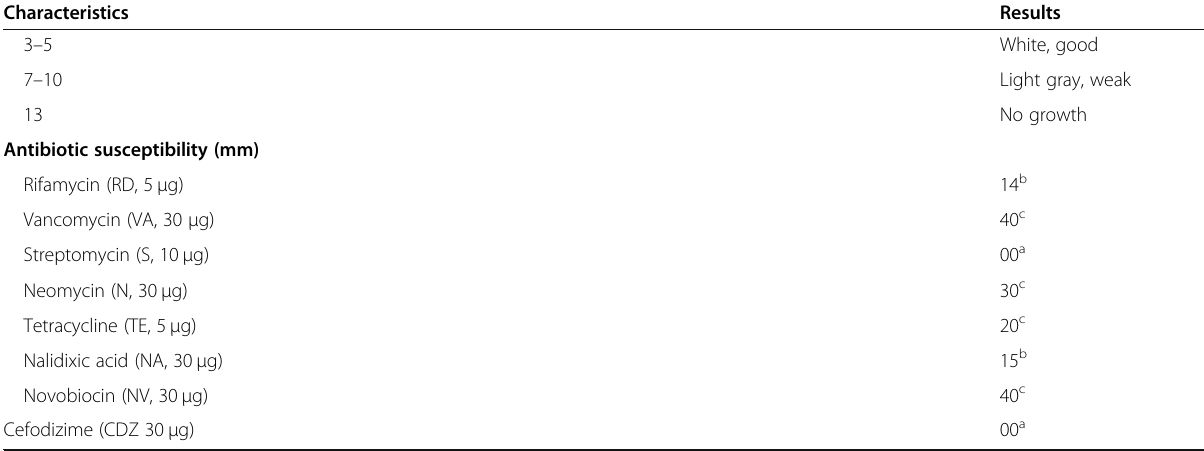
Table 2 Morphological, physiological, and biochemical properties and amino acid utilization of Streptomyces sp. SBLWN_MH2 (Continued)